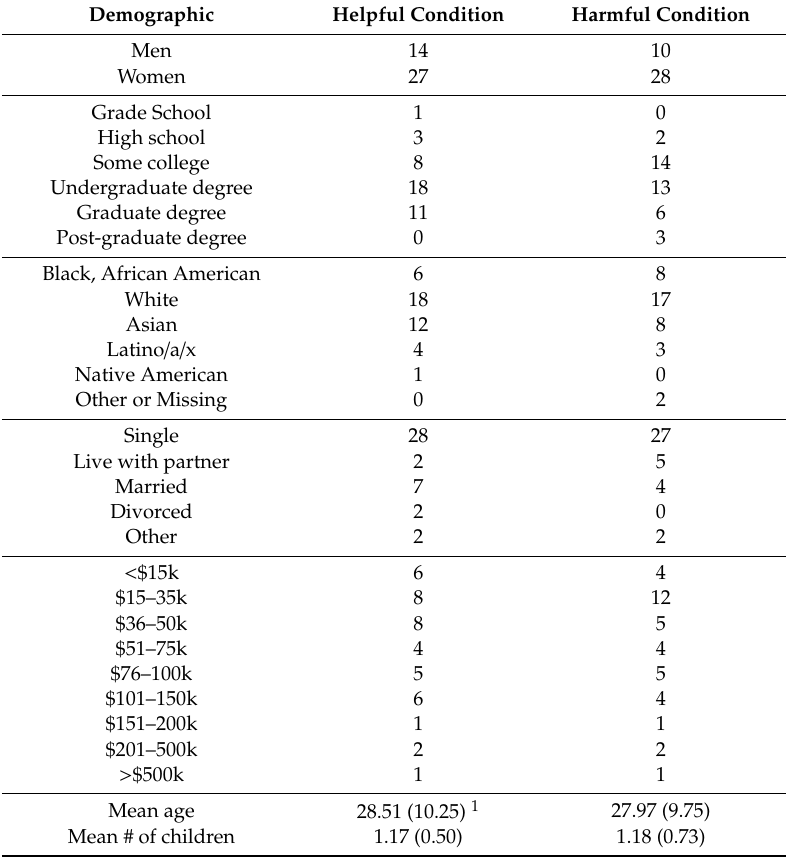
Table 1. Demographics by experimental